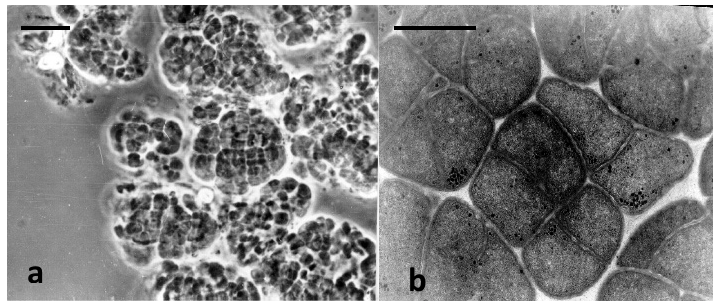
Figure 1. Micrographs of strains JL01 cells: ( a )–phase-contrast microscope, bar 10 μ m; ( b )–ultra-thin section, bar 1 μ